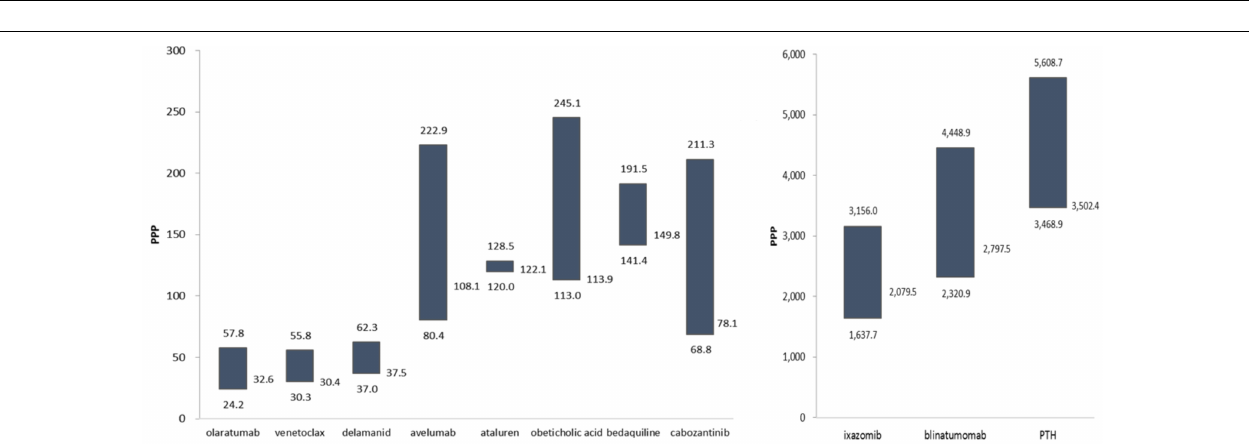
FIGURE 3 | Number of reimbursed medicines and listing rate by country. NB: Redbook was referenced for the United States and brackets = % of reimbursed (listed) medicines out of those approved.